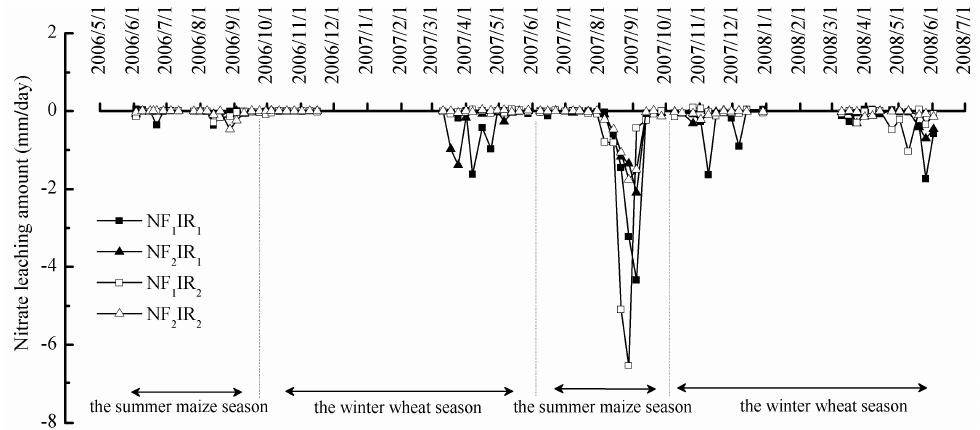
Figure 6. Nitrate leaching amounts under different N and irrigation management practices during the experiment. Negative values are represented by moving downward only.